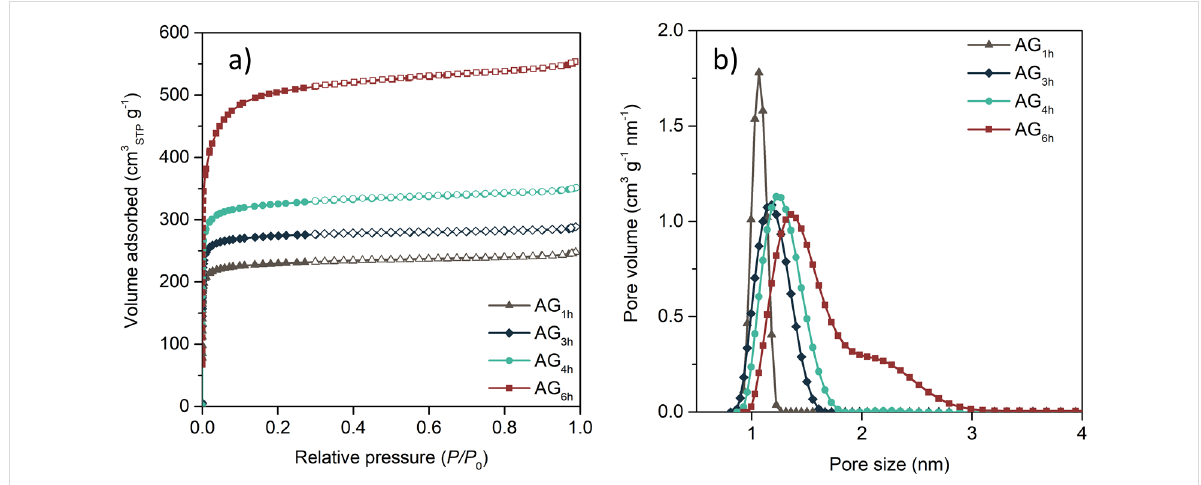
Figure 1: N 2 adsorption/desorption isotherms (a) and pore size distributions (b) of the activated